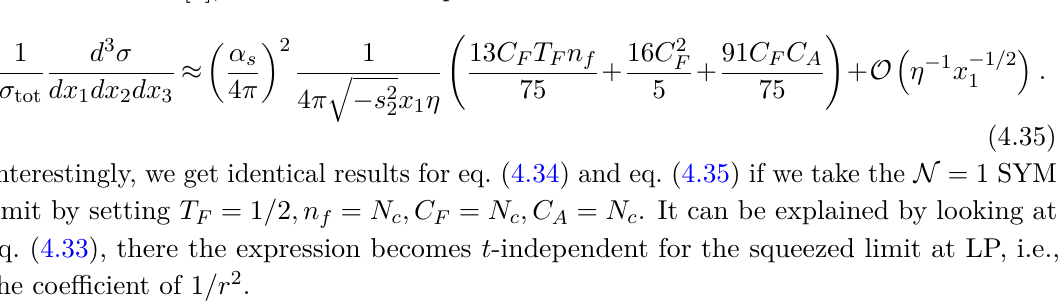
Figure 8 . (a) The triangle formed by the three angular distance triple collinear limit. We introduce the distance r from the origin to the top point and the angle θ between this side and the x-axis. (b). The squeezed limit with isosceles constraints x In the triple collinear limit, this path becomes a circle | z − 1 | = 1